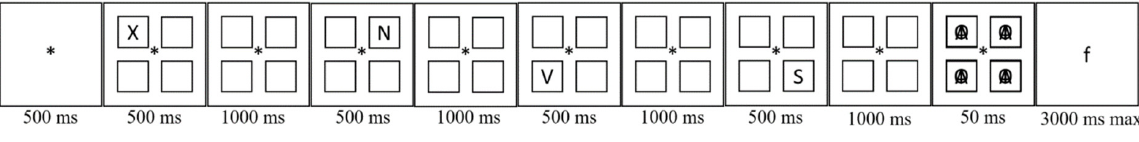
Figure 1. Illustration of the events on a single trial.